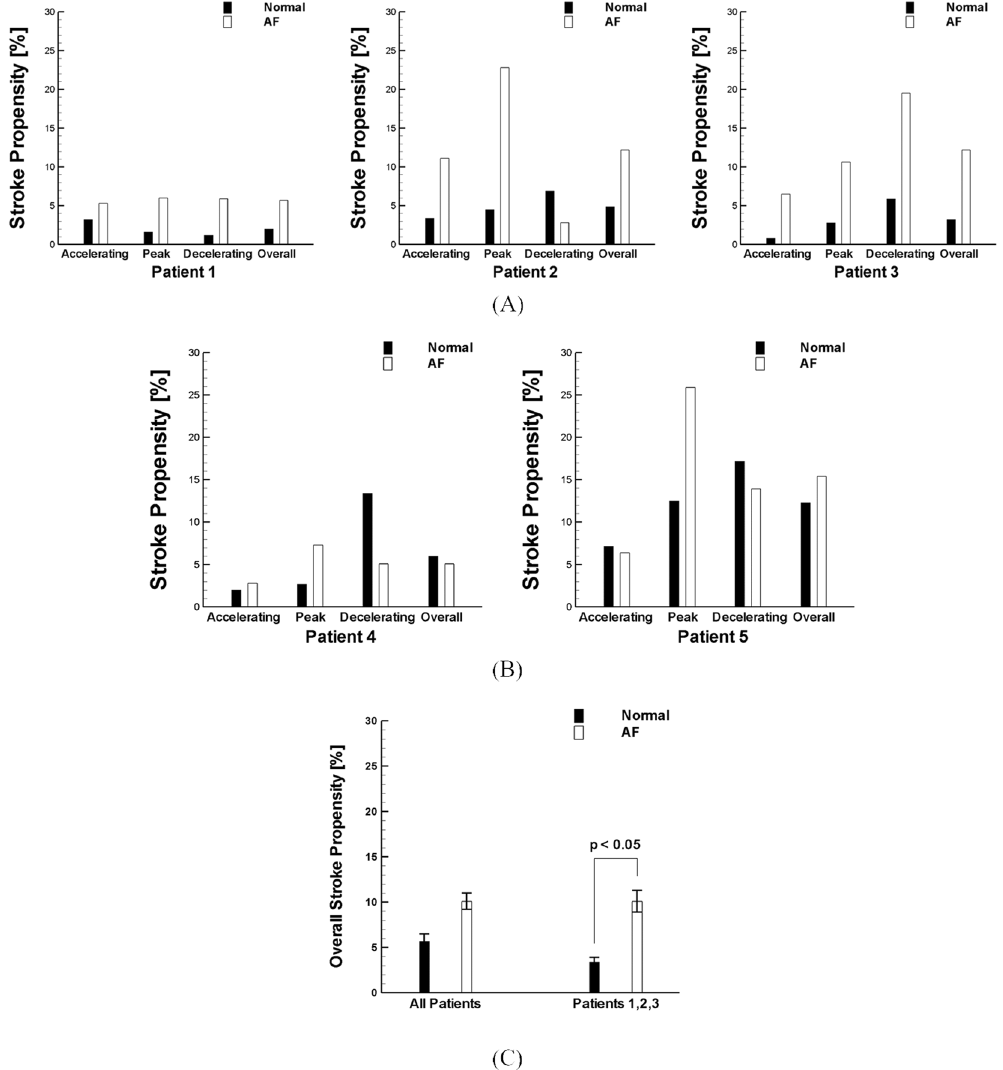
Figure 4. Stroke propensity through LCCA for various ejection instances (i.e., accelerating, peak, and decelerating stage of a cardiac cycle) and overall stroke propensity for various aorta models from ( A ) patient 1, 2, and 3 and ( B ) patient 4 and